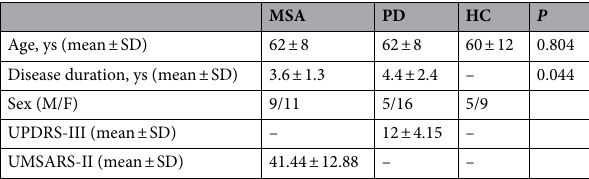
Table 1. Demographic and clinical findings of enrolled